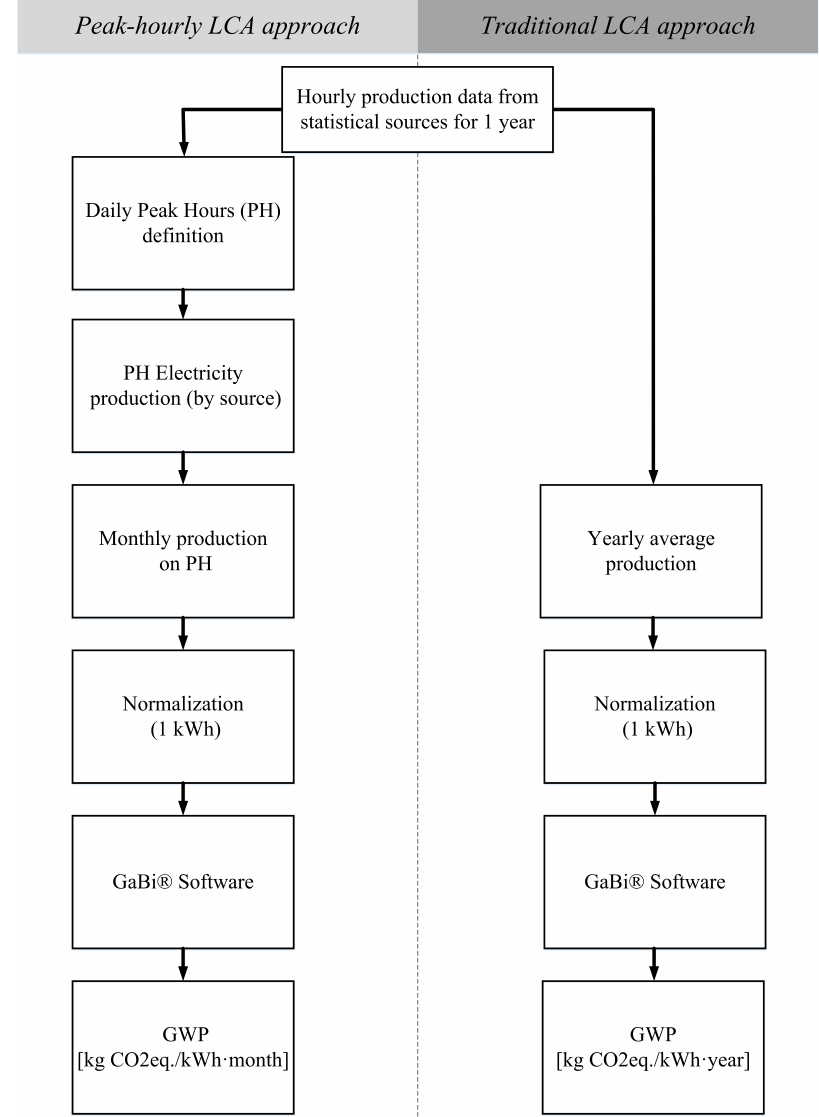
Figure 2. LCA methodology for peak hours electricity